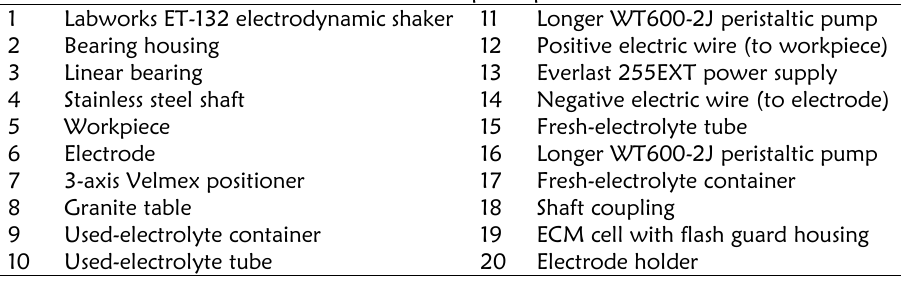
Table 1: ECM set-up components